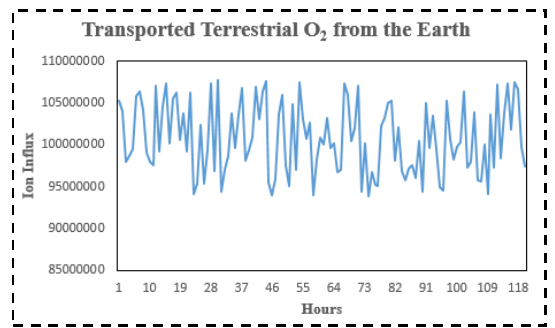
Figure 9. Simulated transported O 2 from the Earth to the lunar surface during solar blackout